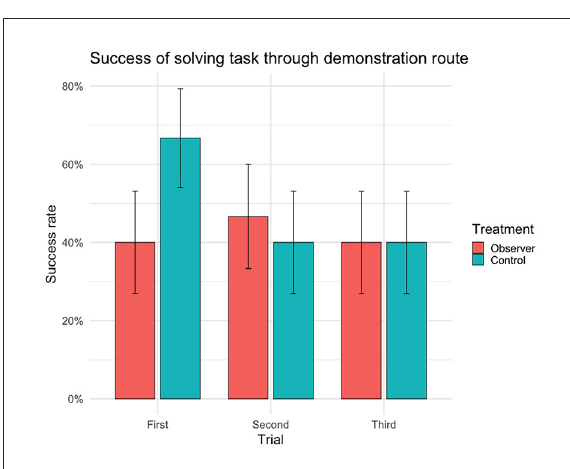
FIGURE3 Success rate (sample mean) of reaching the yellow reward bucket and solving task within 90 s through demonstration route (i.e. achieving complete success) for each trial ( n = 30 cows, 90 trials). Error bars indicating